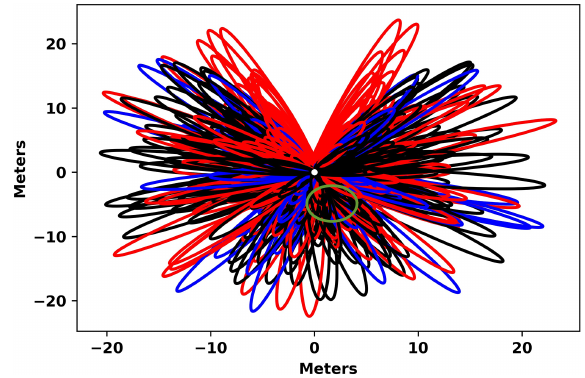
Figure 1. Principle of the Global Navigation Satellite System inter- ferometric reflectometry (GNSS-IR). H O is the antenna height and θ it the satellite elevation angle.